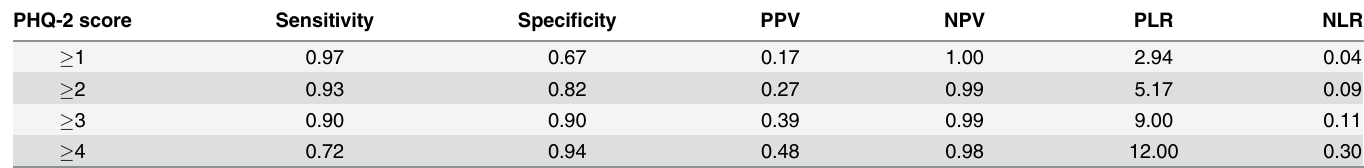
Table 4. Sensitivity, specificity, predictive values, and likelihood ratios at various cut-off scores of the PHQ-2. PHQ-2 score